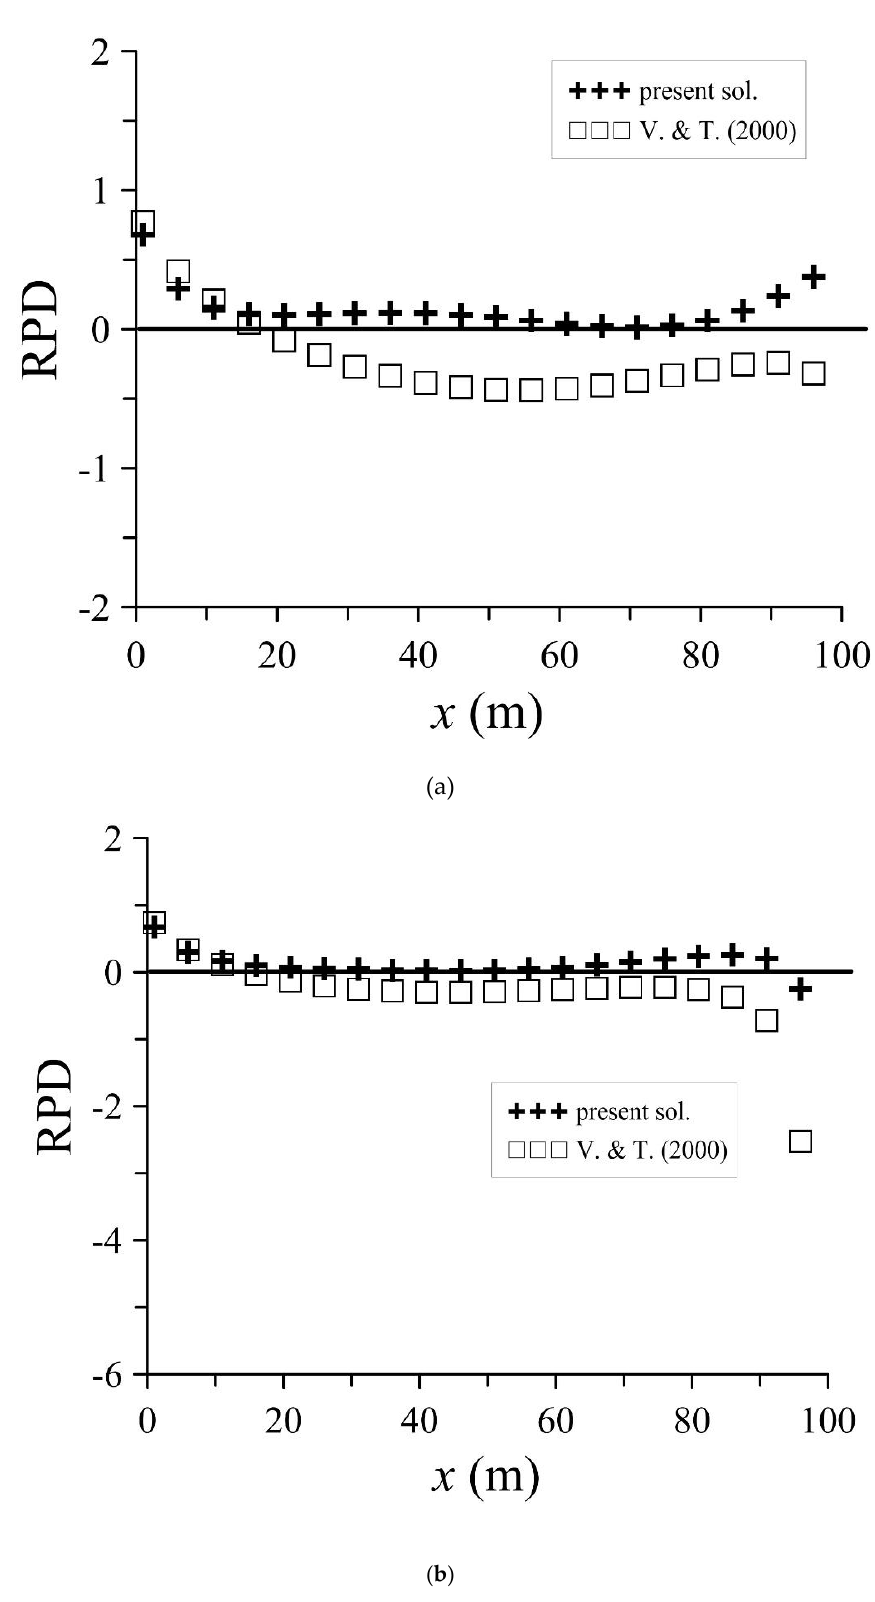
Figure 5. Relative percentage difference (RPD) between analytical and numerical solutions. ( a ) 𝜃 = 2° ( b ) 𝜃 = 6° ( t = 1 day).